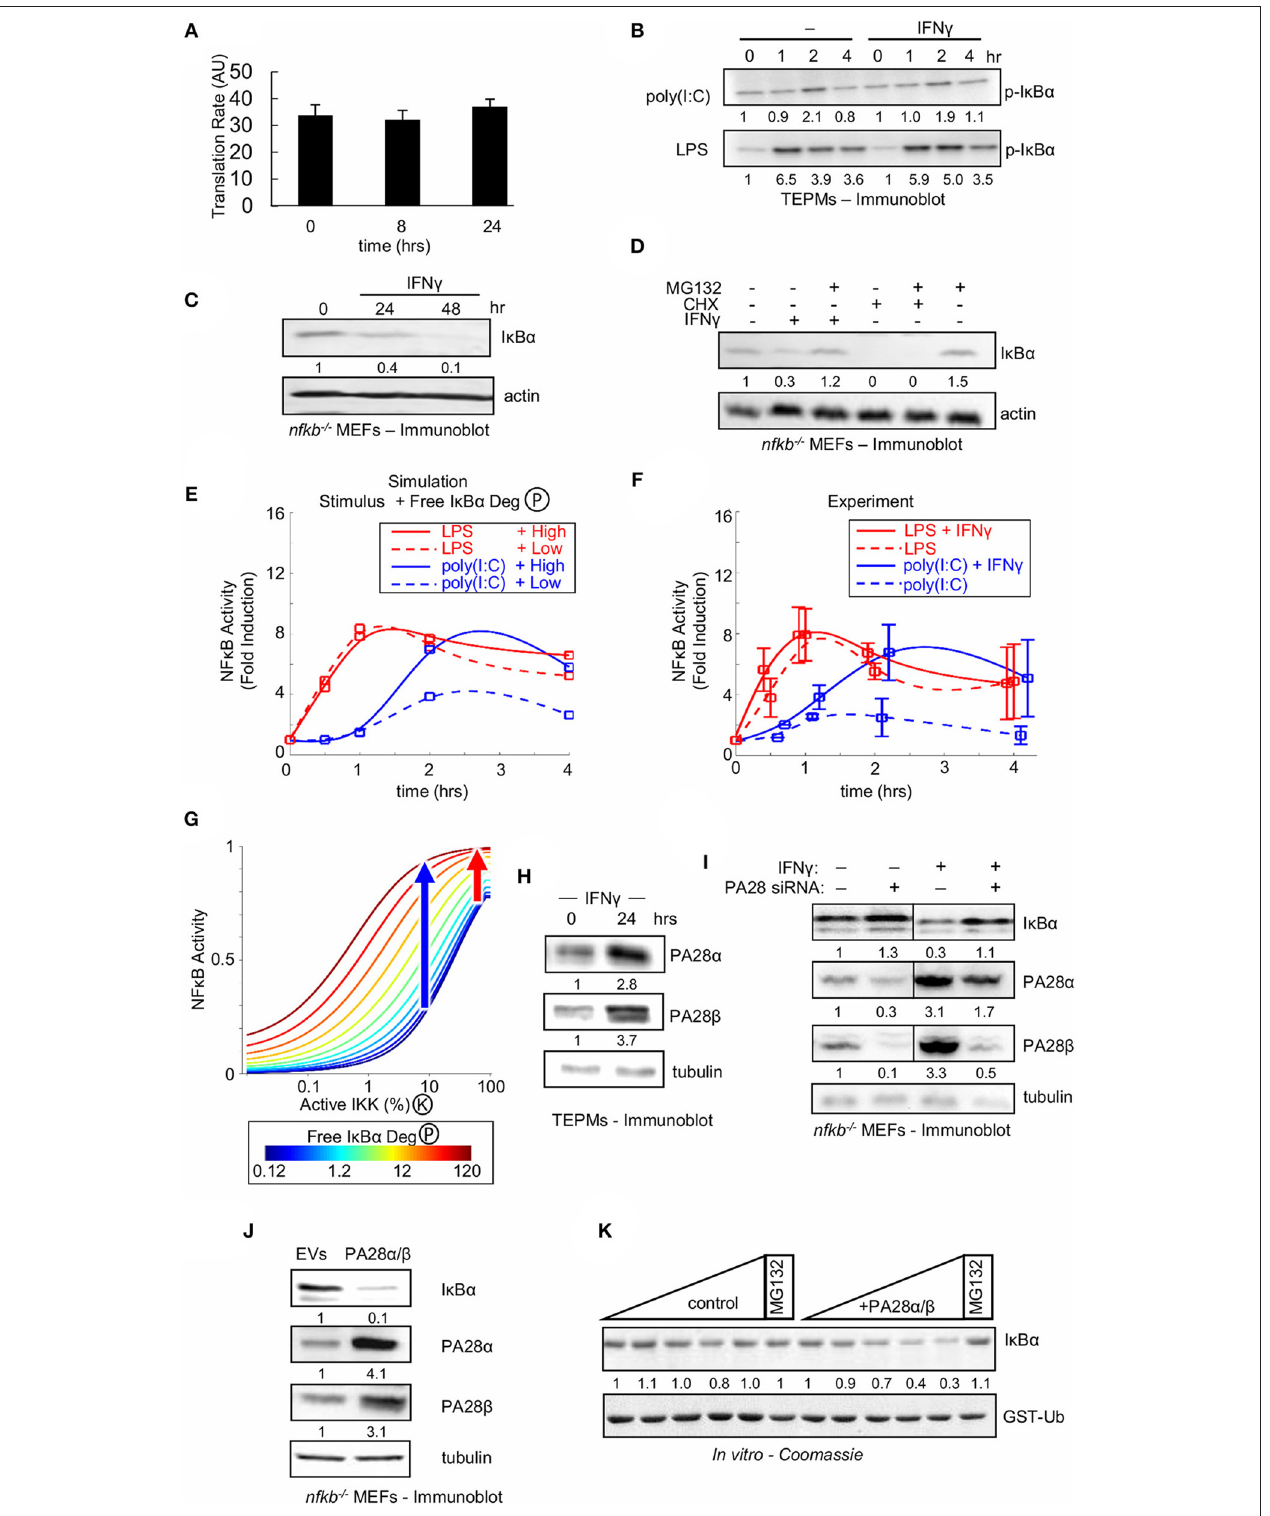
FIGURE 5 | Type II interferon amplifies weak NF κ B activating stimuli by enhancing free I κ B α degradation. (A) I κ B α translational synthesis rates in naïve and IFN γ -conditioned TEPMs as revealed by 35 S-Met pulse assay. Average and standard deviation of three biological replicates are shown. (B) Immunoblot for p-I κ B α